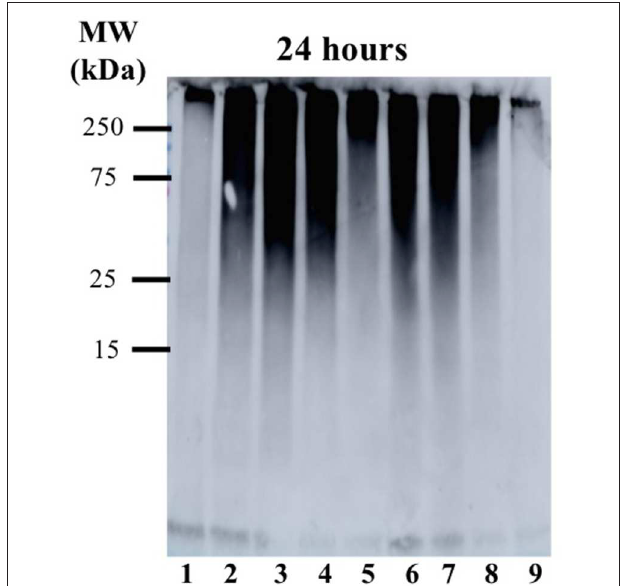
FIGURE 5 | Gel electrophoresis/Western blot of 25 µ M A β 1 − 42 and different concentrations of Ru-N-1 and Ru-N-4 in PBS buffer (0.01M, pH 7.4) at 24h incubation with agitation at 37 ◦ C, using anti-A β antibody 6E10. Lane 1: A β 1 − 42 ; lane 2: A β 1 − 42 + 0.25 eq. Ru-N-1 ; lane 3: A β 1 − 42 + 0.5 eq. Ru-N-1 ; lane 4: A β 1 − 42 + 1 eq. Ru-N-1 ; lane 5: A β 1 − 42 + 2 eq. Ru-N-1 ; lane 6: A β 1 − 42 + 0.25 eq. Ru-N-4 ; lane 7: A β 1 − 42 + 0.5 eq. Ru-N-4 ; lane 8: A β 1 − 42 + 1 eq. Ru-N-4 ; lane 9: A β 1 − 42 + 2 eq. Ru-N-4